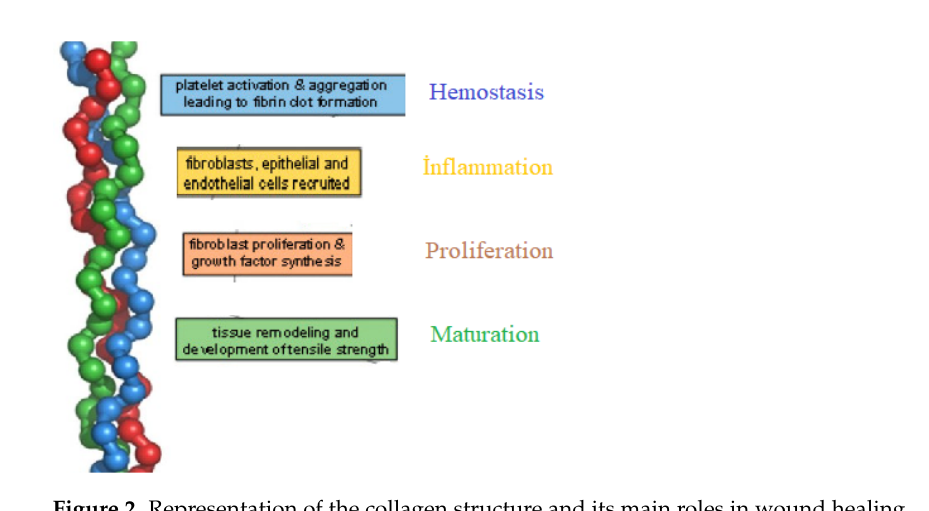
Figure 2. Representation of the collagen structure and its main roles in wound healing.